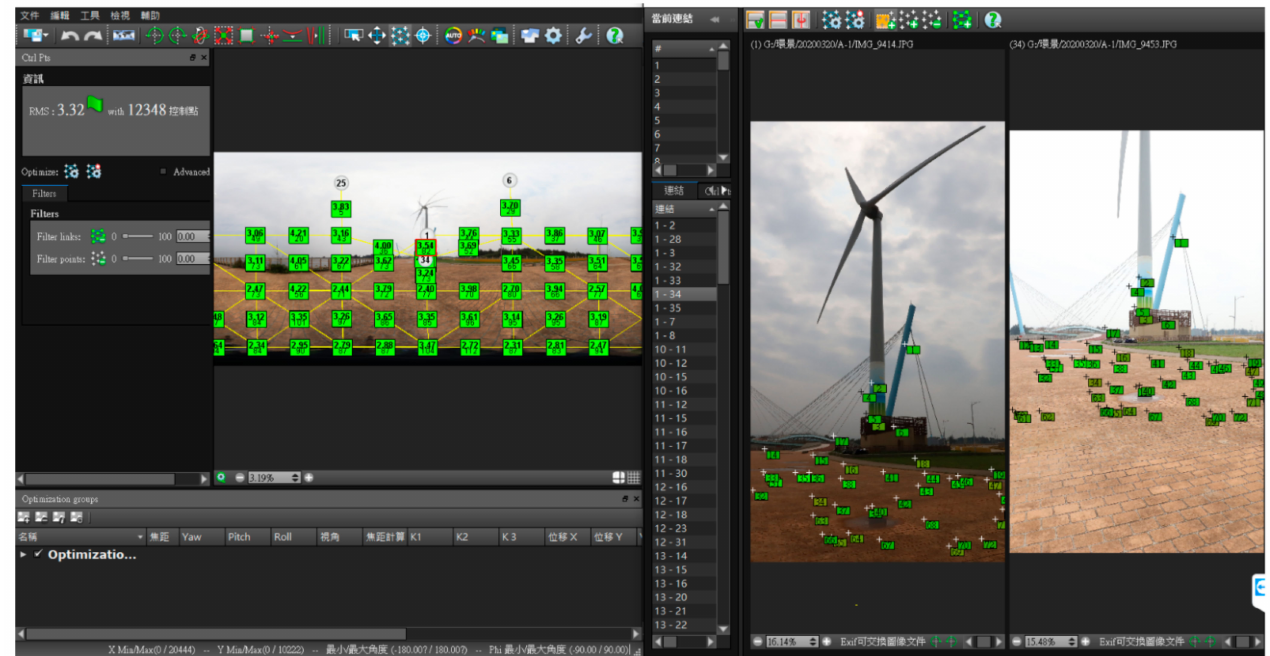
Figure 6. Quality illustration of tie points (left) and the edited interface (right) in Autopano after stitching a panoramic